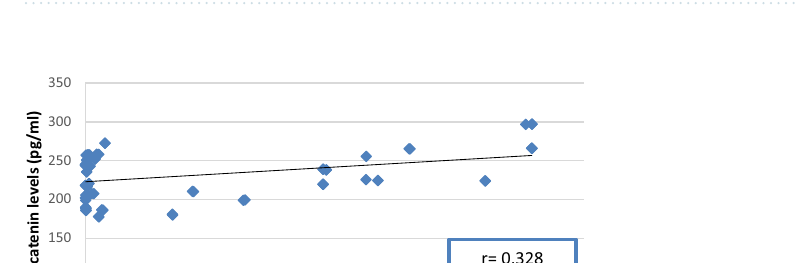
Figure 6. ( a ) Correlation between fold change of Znhit1 gene expression and β-catenin levels (pg/ml) in breast cancer tissues. ( b ) Correlation between fold change of Znhit1 gene expression and serum β-catenin levels (pg/ ml) in breast cancer patients.